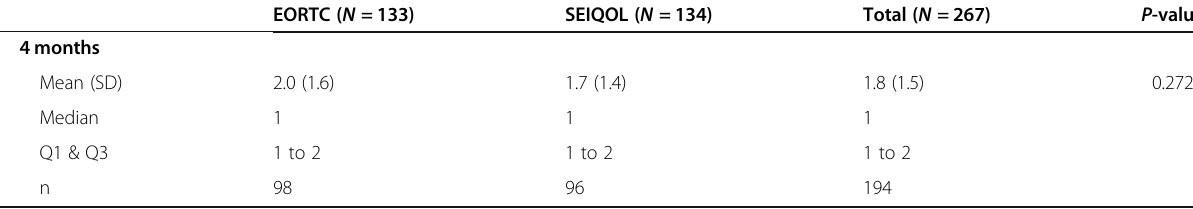
Table 2 Outcomes a over time for analyzed patients